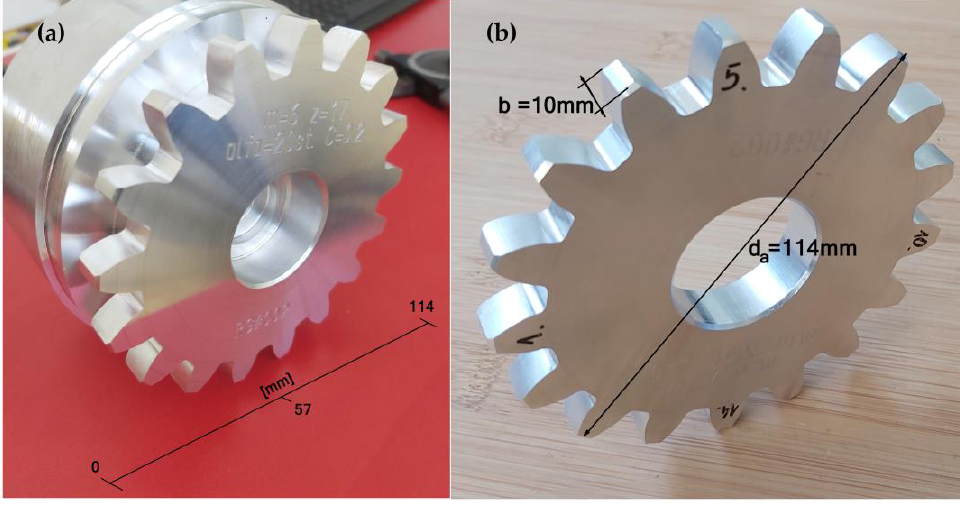
Figure 8. The machined gear. ( a ) the machined gear, ( b ) the cut off gear rim with indicated tooth samples machined with different feed rates.